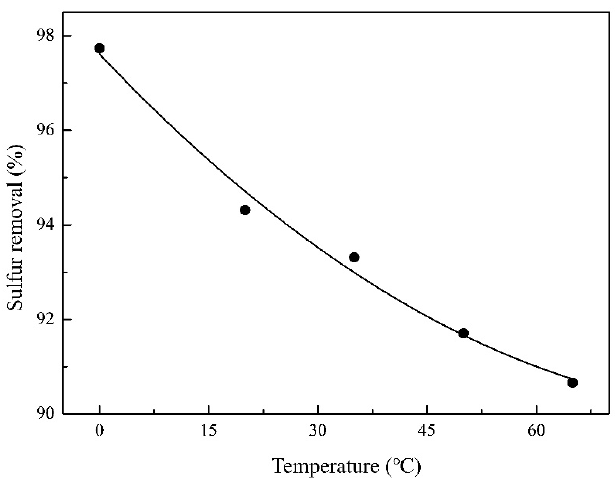
Figure 6. The effect of temperature on DBT removal. Experimental conditions: initial sulfur concentration, 500 ppm; catalyst dosage, 2.5 wt.% of n -octane; ozone dosage, 0.1 g/h; reaction time, 60 min.